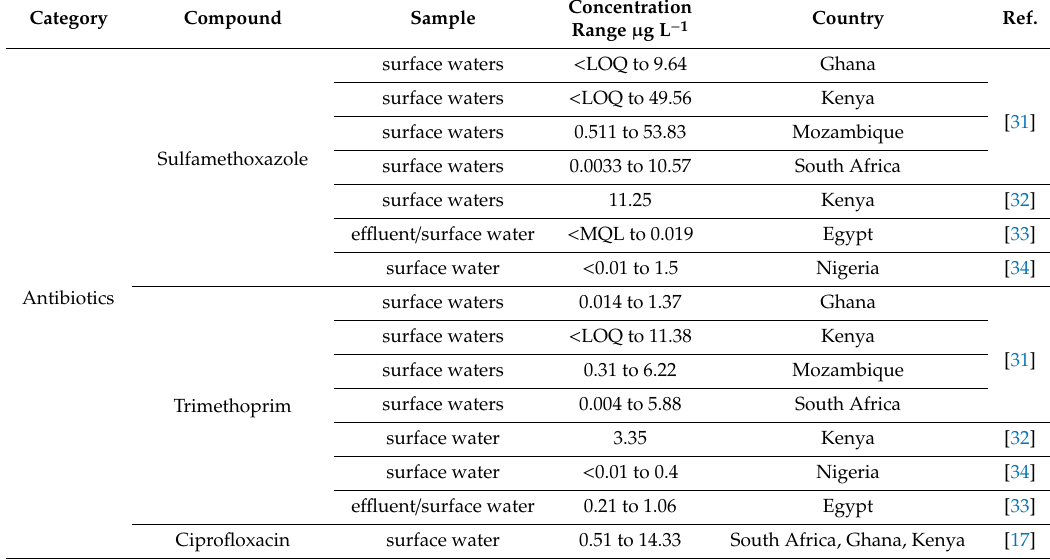
Table 5. Occurrence of antibiotic and antiretroviral drug residues in selected African surface waters and WWTP e ffl uents. < LOQ = below limit of quantification, < MQL = below method quantification limit, n.d. = not